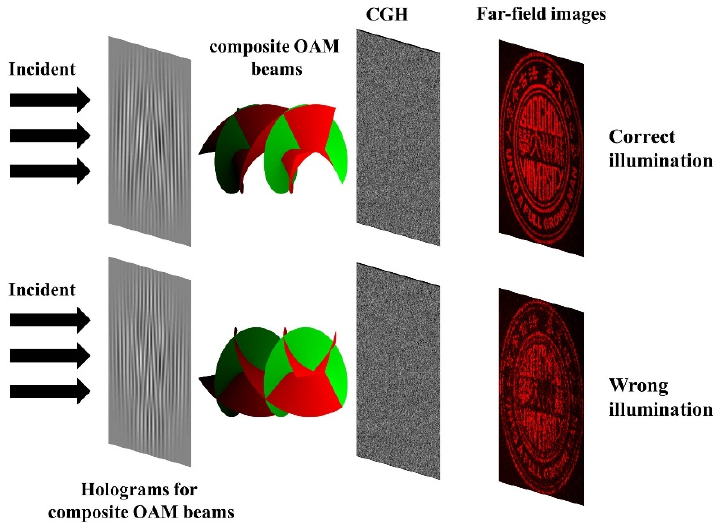
Figure 1. Schematic diagram of the composite OAM phase holography. Decoding of the CGH with the correct composite OAM beam: the encoding image appears in the far-field (the logo of Soochow University).